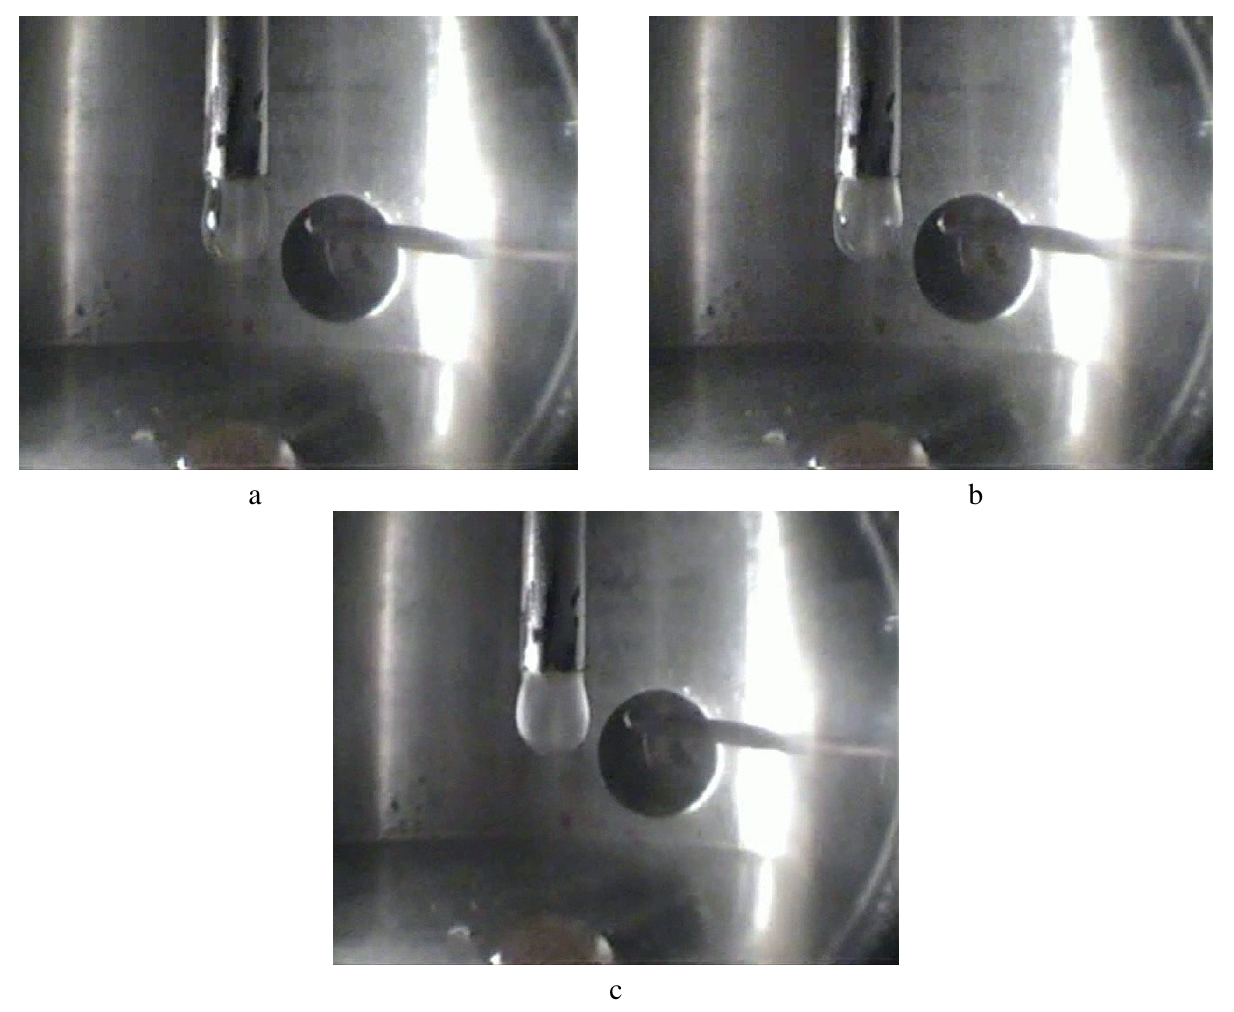
Figure 6. (a) Water droplet; (b) hydrate formed on ~2/3s of droplet; (c) full hydrate on droplet in ~1.0 sec.